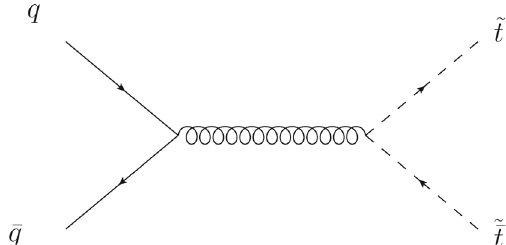
Fig. 41 Feynman diagram of a stop squark pair production by quark annihilation